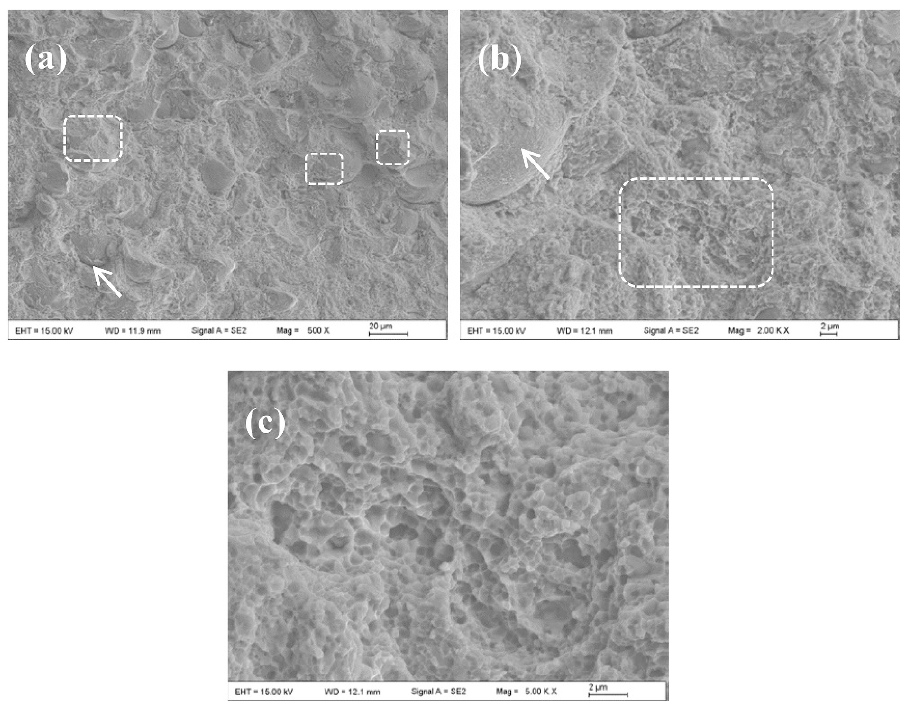
Figure 18. SEM morphologies of fractured surface of the SLD Stellite 6 coating specimen ( a ) and ( b ) spherical particle surfaces with tearing edges as marked by boxes and arrows. ( c ) the first morphology suggests the rupture at particle–particle interface [78].